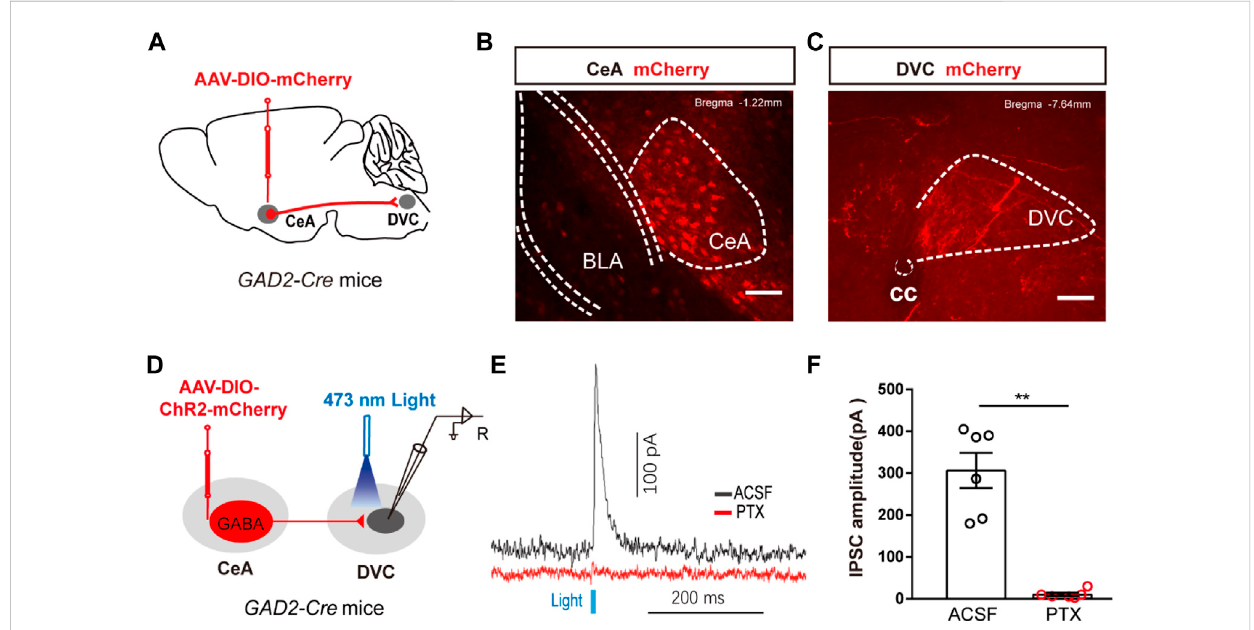
FIGURE 4 TheanatomicalandfunctionalconnectionbetweenCeA GABA → DVCpathway (A) Schematicoftheviralinjection. (B,C) Representativeimagesofviral expression in the CeA (B) and mCherry signals in the DVC (C) . Scale bars: 100 µm. (D) Schematic of viral injection in GAD2-Cre mice and the whole-cell recordingcon fi gurationinbrainslices. (E,F) Representativetraces (E) andsummarizeddata (F) ofinhibitorypostsynapticcurrents(IPSCs)inDVCneurons inducedbyphotostimulation(473 nm,bluebars)ofCeA GABA terminalsintheDVCinthepresenceofACSFortheGABA A receptorantagonistPTX( n = 6 cells from three